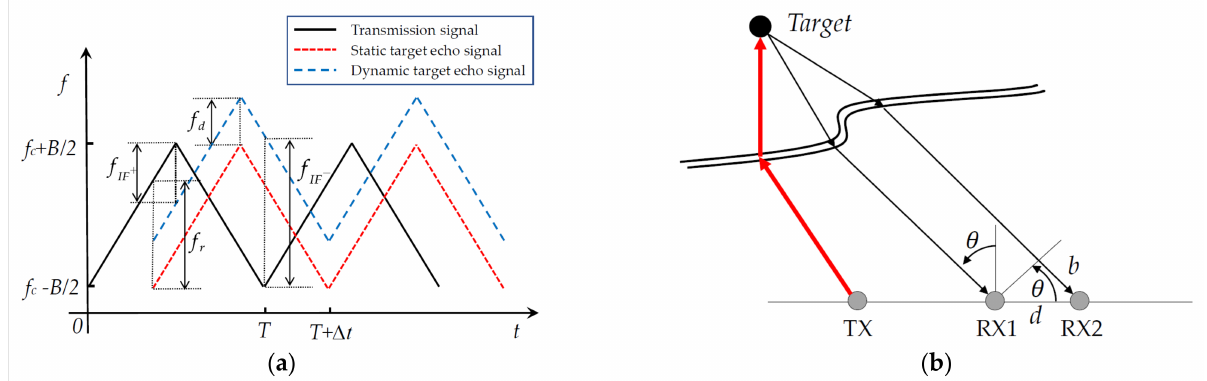
Figure 1. ( a ) Linear frequency modulation continuous wave (LFMCW) radar signal waveform processing; ( b ) principle of azimuth measurement of the target. TX is the transmitting antenna, and RX is the receiving